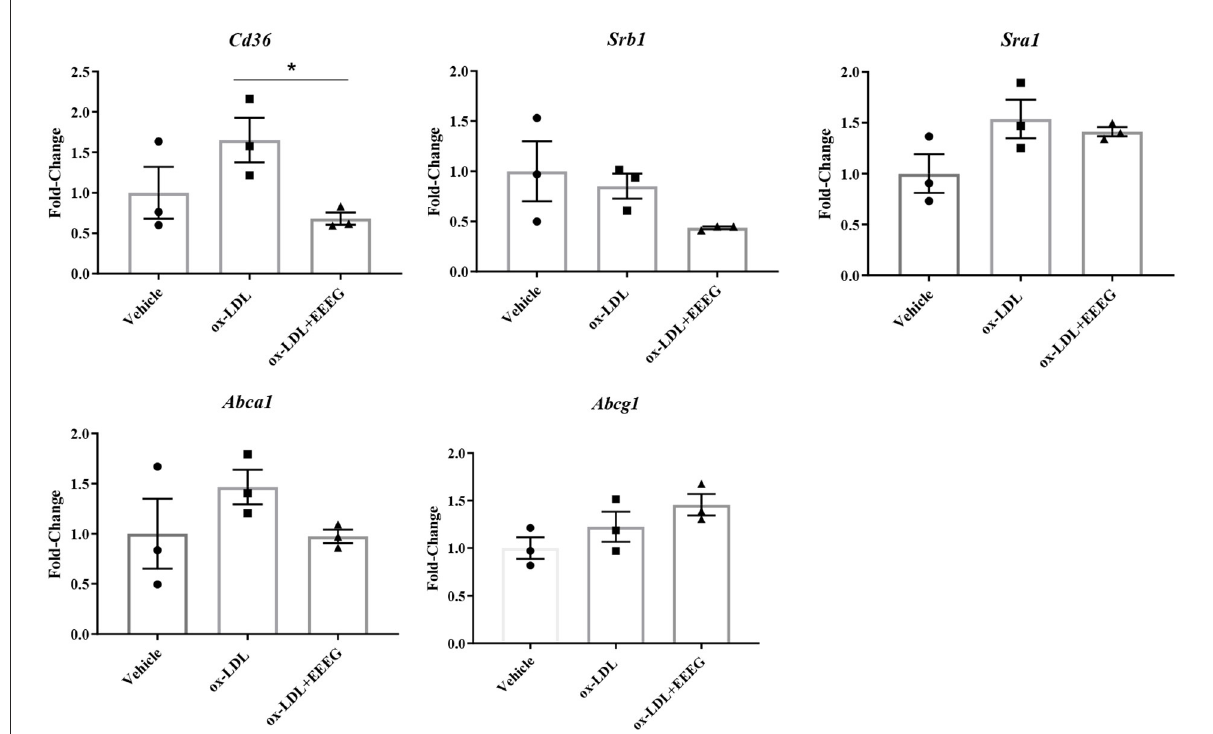
FIGURE4 EEEG treatment reduces expression levels of genes involved in ox-LDL uptake. Expression levels of cholesterol homeostasis-related genes involved in uptake and efflux of ox-LDL in BMDM. Data are expressed as mean ± s.e.m., Statistical analysis was based on Graphpad Prism 9.0.2 software and a value of P < 0.05 was considered statistically significant. One-way ANOVA with Student Neuman-Keuls post-hoc test was performed to compare the data between multiple groups, * p <